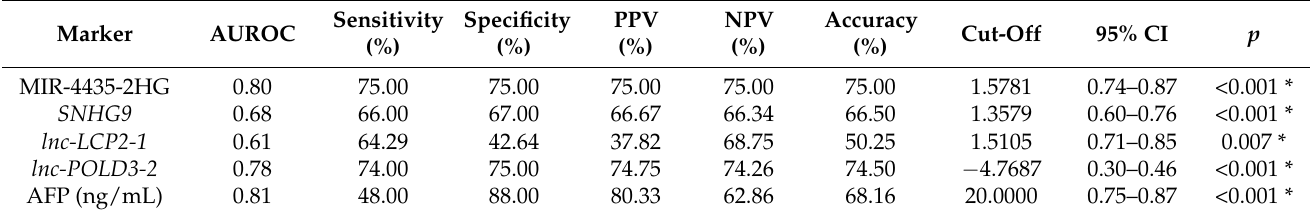
Table 2. Summary of diagnostic performance of lncRNAs.